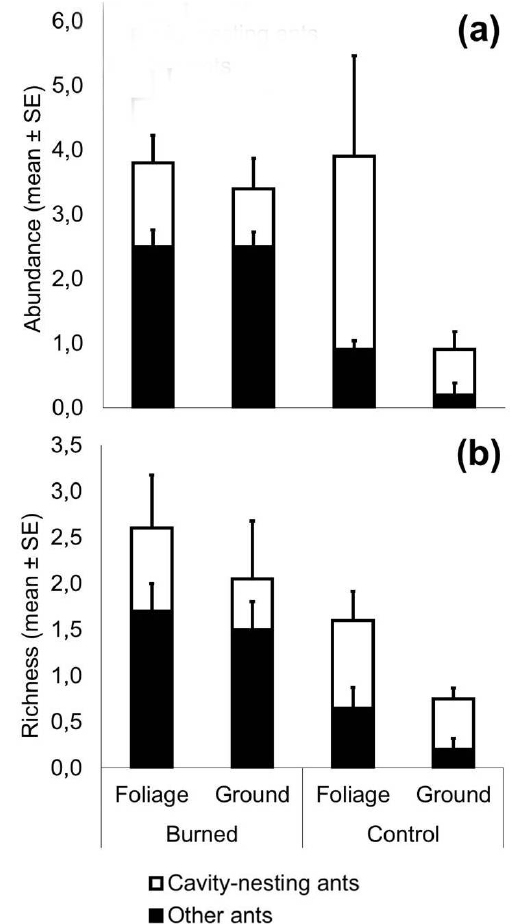
Fig 1 . Contrasts between burned and unburned areas of Cerrado for ant diversity. Ants presents higher abundance (p = 0,01) in the burned area but lower percentage (p = 0,01) of cavity-nesting ants (a). The same is true for ant richness (p = 0,002) and percentage of cavity-nesting species (p = 0,002;